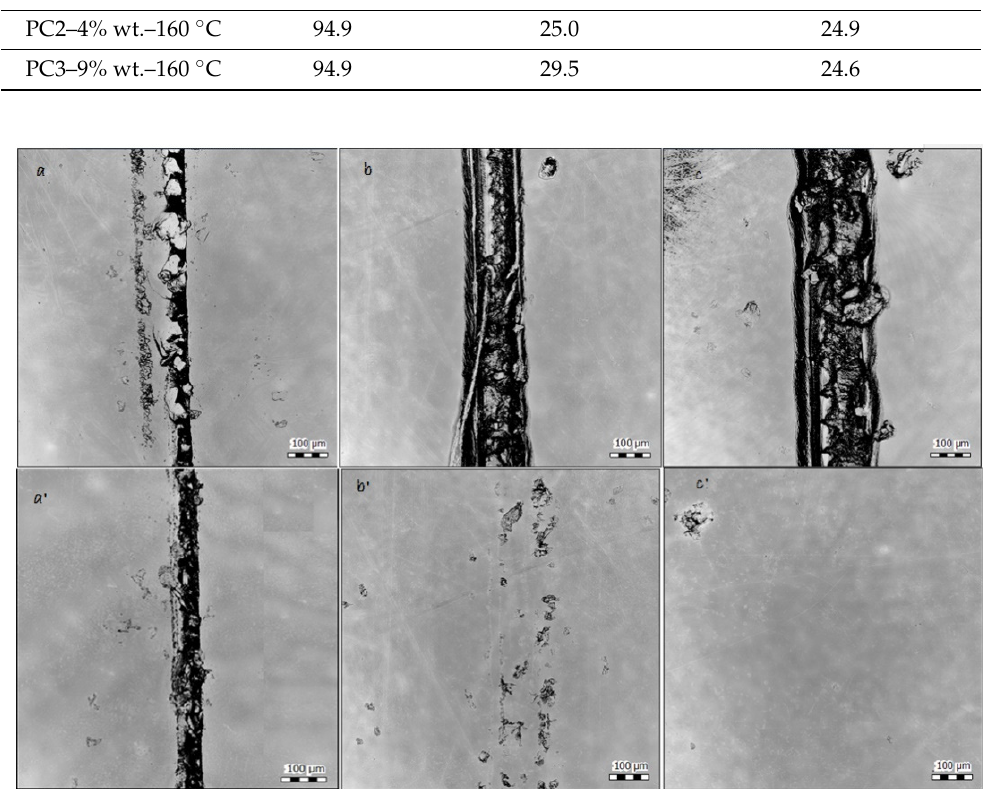
Figure 10 . Surface scan of samples before and after being held at 120 °C for 30 min by